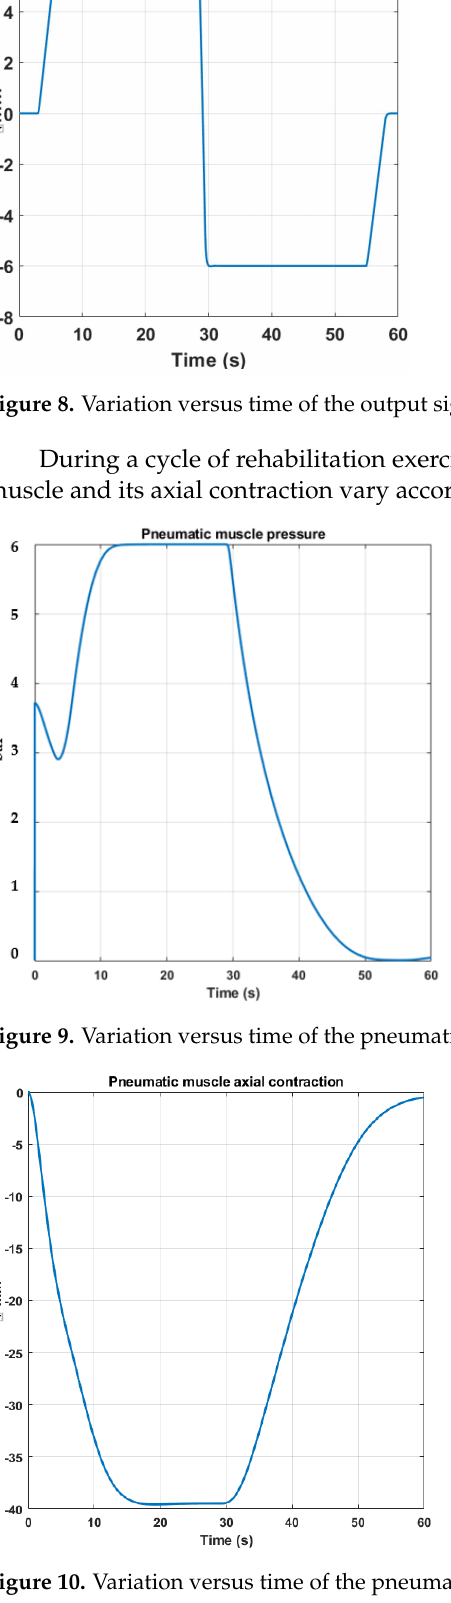
Figure 11. Varia tion versus time of the rotation angle of lever AB. Figure 12. Variation versus time of the angular velocity of lever AB. Figures 11 and 12 were obtained by means of the Ideal Rotational Motion Sensor block that measures the angular velocity and/or rotation angle of the rotating components